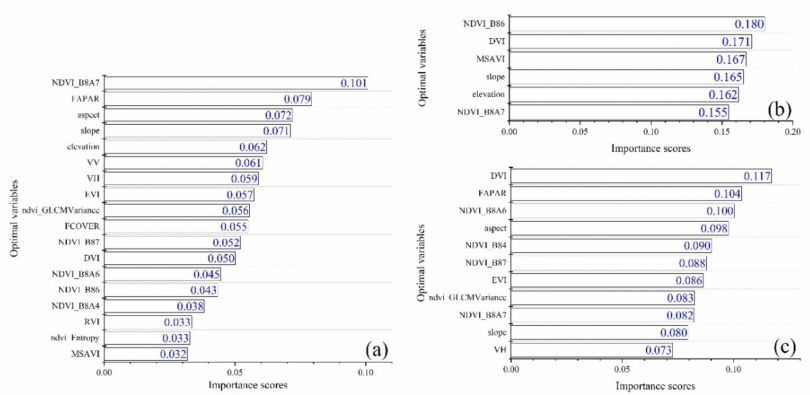
Figure 10. The optimal variables for each forest type and importance score for each variable in descending order. ( a ) Coniferous forest, ( b ) broadleaf forest, and ( c ) mixed